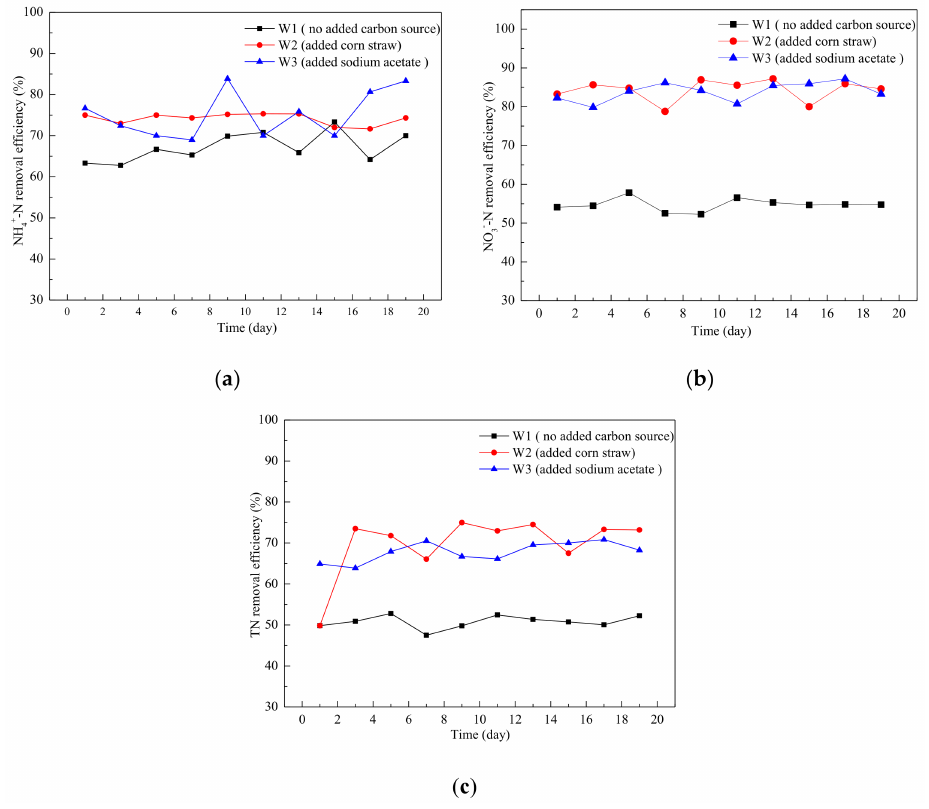
Figure 5. Effects of external carbon source on nitrogen removal; ( a ) NH 4+ -N; ( b ) NO 3 − -N; and ( c )